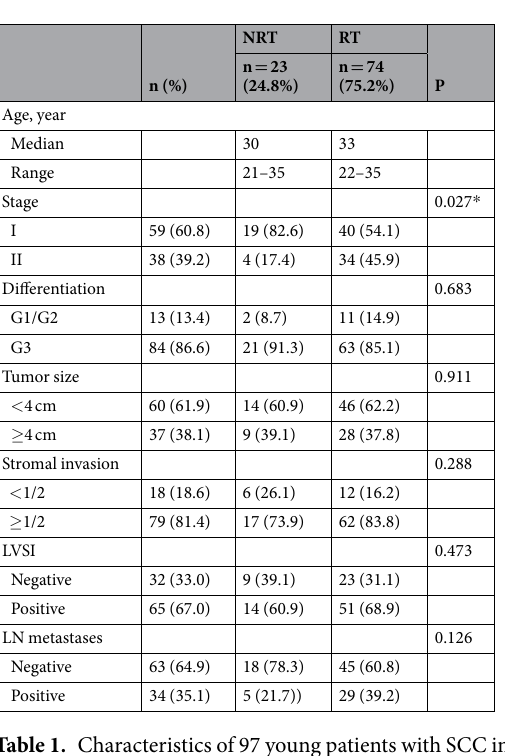
Table 1. Characteristics of 97 young patients with SCC in two study groups. * P < 0.05.